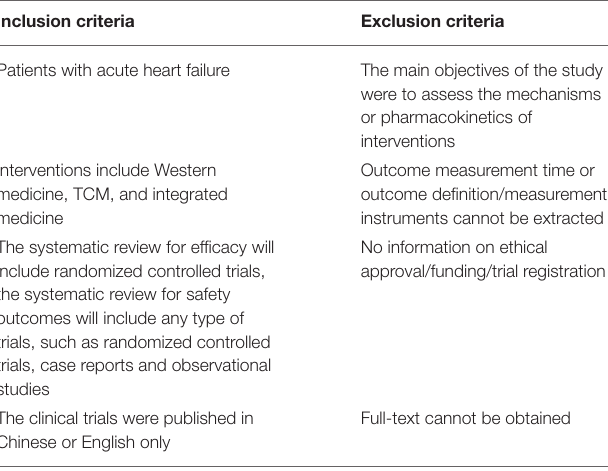
TABLE 2 | The inclusion and exclusion criteria of systematic reviews for reported outcomes. Inclusion